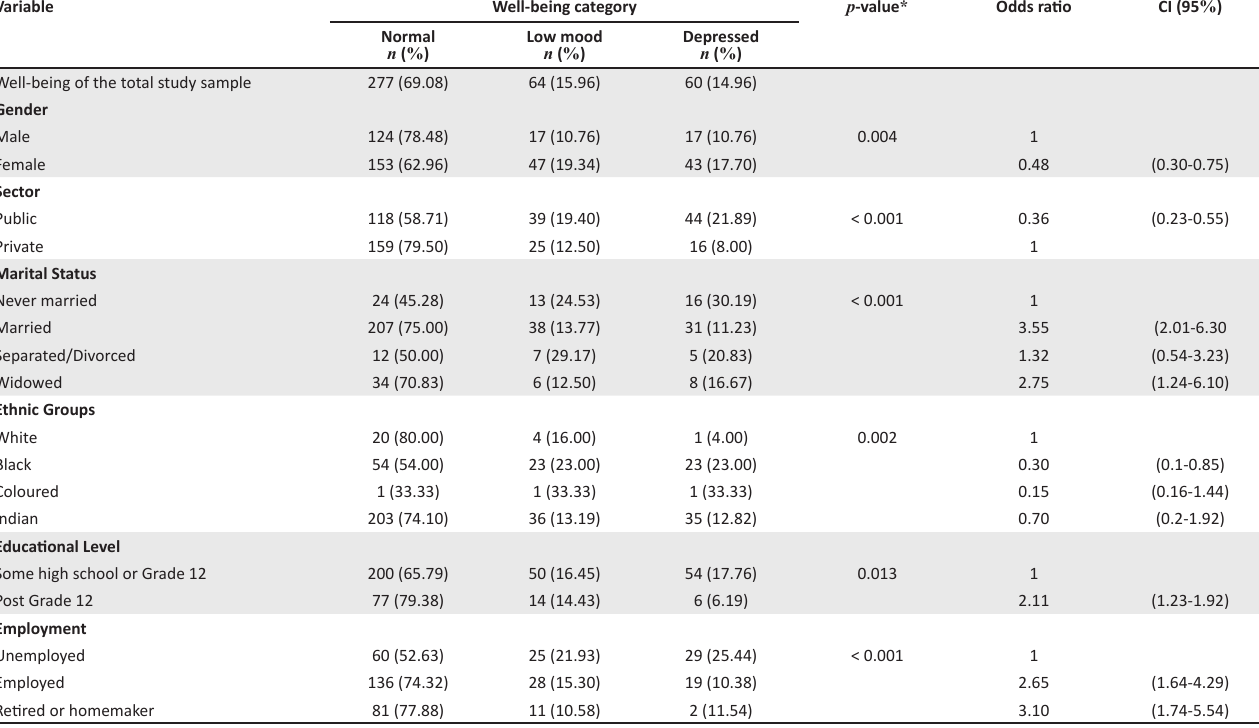
TABLE 2: Levels of well-being by gender, sector, marital status, ethnicity, education and employment.